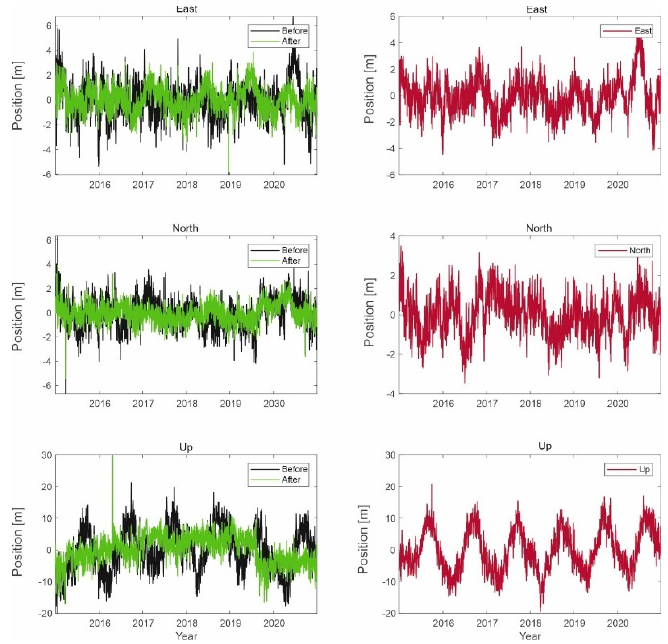
Figure 14. Signal processing in the Galileo receiver operating on the L1 frequency; on the left side, the signal waveform in color without the noise suppression system applied; on the right side, the working system operating in the LTE system signal elimination for the reception of signals from five satellites.